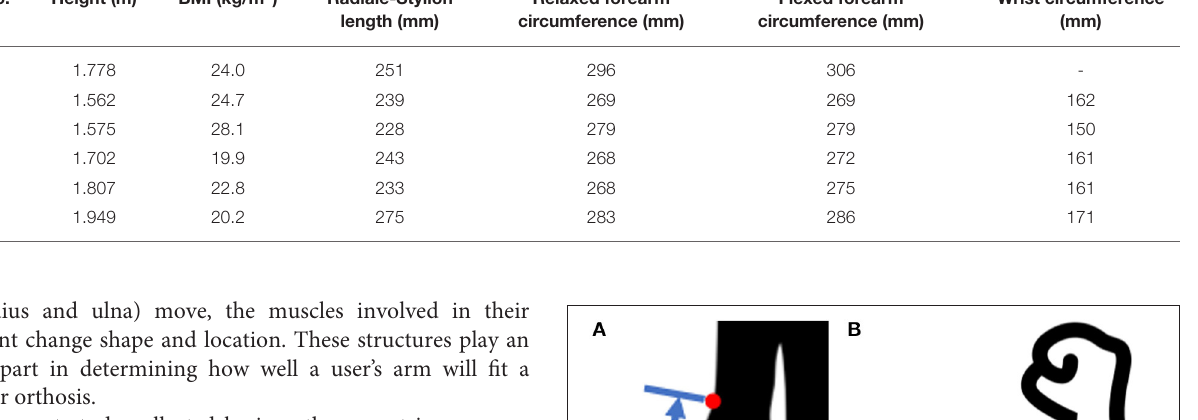
TABLE 1 | The anthropometric data collected from the six subjects in the study. Subject no.